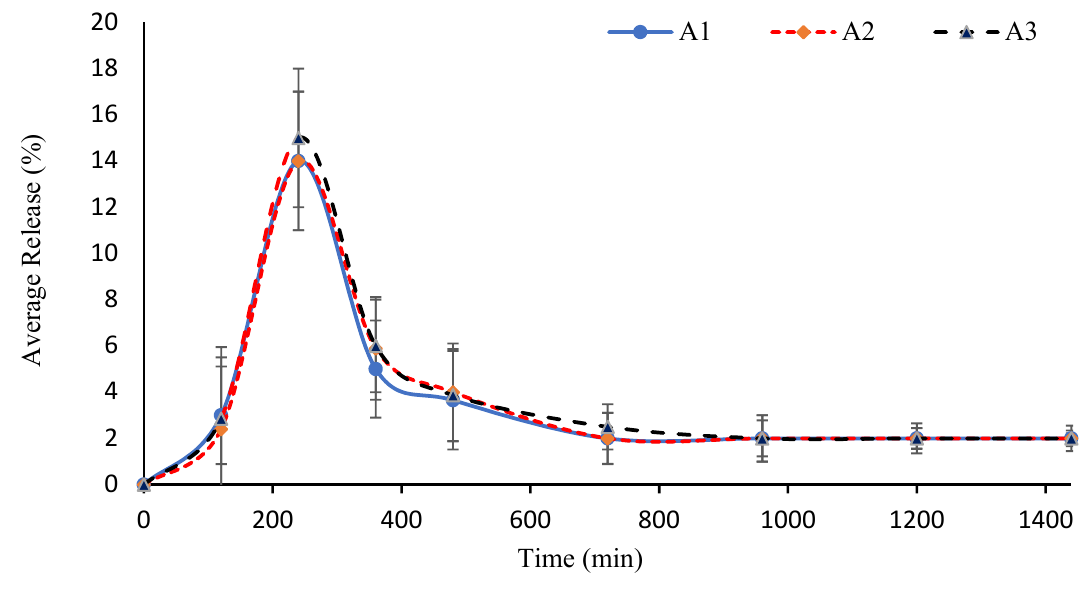
Figure 8. At pH 1.2, effect of AM on 5-FU release.